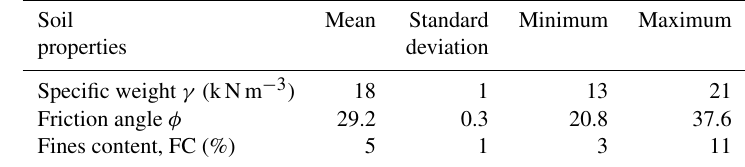
Table 2. Geotechnical parameters of dikes adopted in this study.